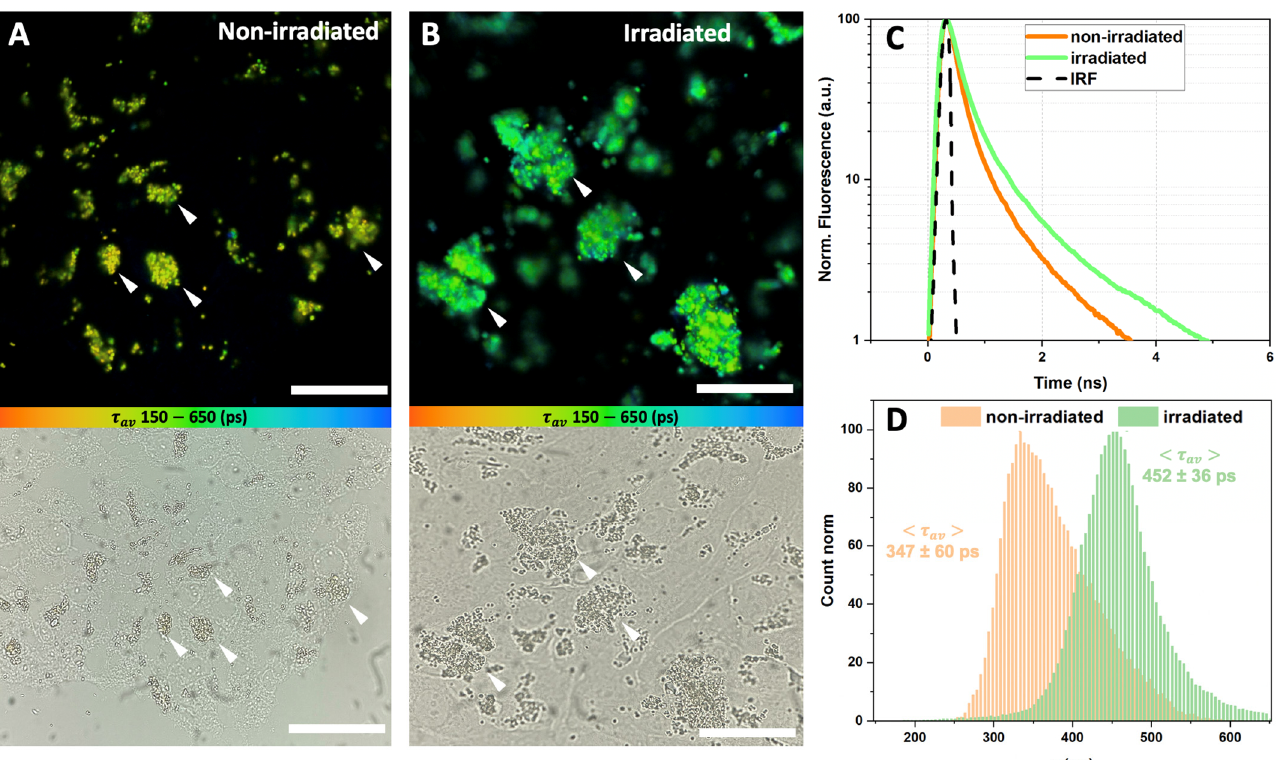
Figure 4. FLIM data on ARPE-19 cells fed with lipofuscin granules, measured at 48 h after white light irradiation. Excitation λ exc: 473 nm; detection λ det: 485 (long pass) nm; color scale encodes the range of average lifetimes from 150 ps (orange) to 650 ps (blue). ( A ) FLIM and transmitted microscopy images of non-irradiated cells; ( B ) FLIM and transmitted microscopy images of irradiated cells; ( C ) fluorescence decay curves, averaged on the set of the curves calculated in each pixel of the corresponding image; ( D ) distribution of fluorescence lifetime in each pixel of the image. Average fluorescence lifetime values ( < τ av > ) were obtained by approximation of distributions with the Gauss function with errors corresponding to the width of the Gaussian. White arrows correspond to the deposition of lipofuscin granules in RPE cells. The measuring bar corresponds to 10 µ m.